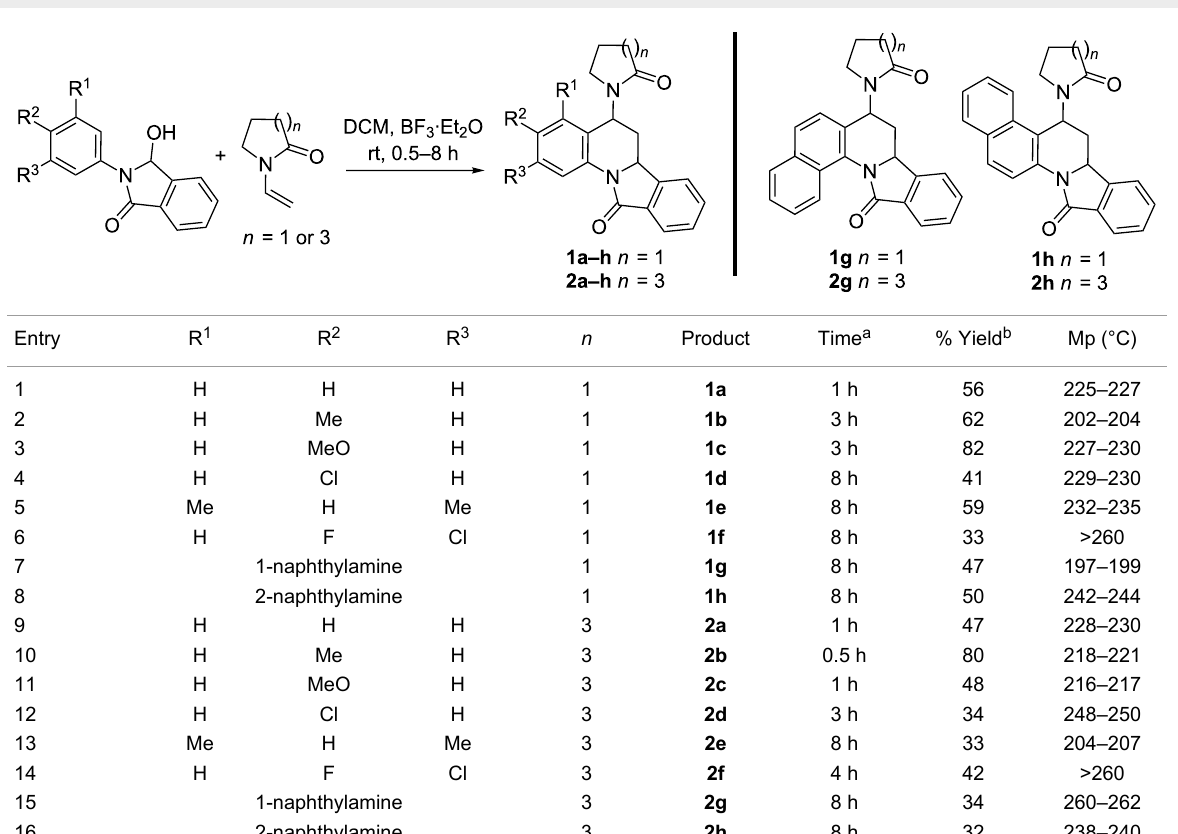
Table 1: Reaction data for the synthesis of compounds 1a–h and 2a–h